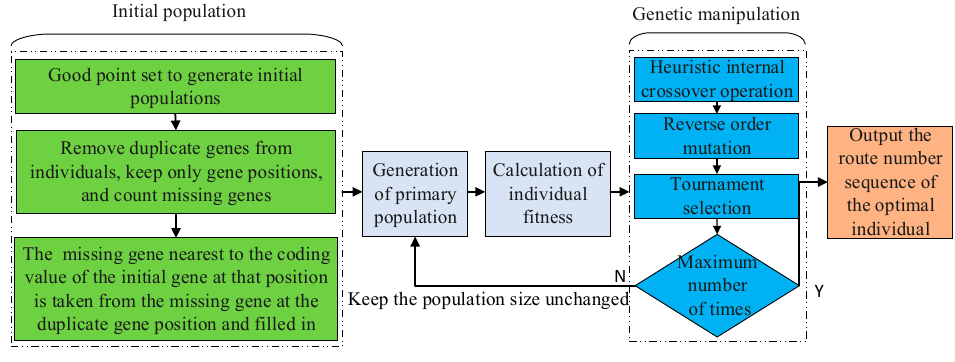
Figure 7. Genetic algorithm flow chart.